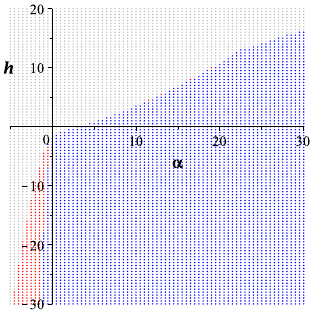
Figure 4 . Possible critical points in ( (cid:11); h ) parameter space for k = 1 , (cid:15) = (cid:0) 1 and q = 0 : possible critical points satisfying entropy and pressure conditions and minimizing the Gibbs free energy. Note that there is a very narrow band where two critical points occur between the boundary of the blue and grey regions in the upper-right quadrant, appearing as a few isolated red dots in the plot. Here red, blue, and grey points indicate two, one, and zero possible critical points